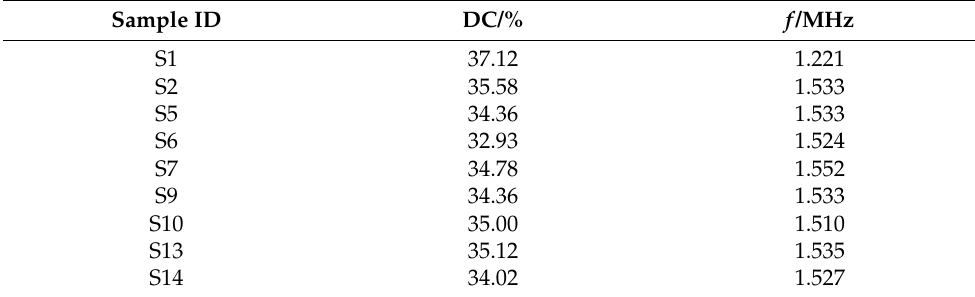
Table 1. Selected sensors